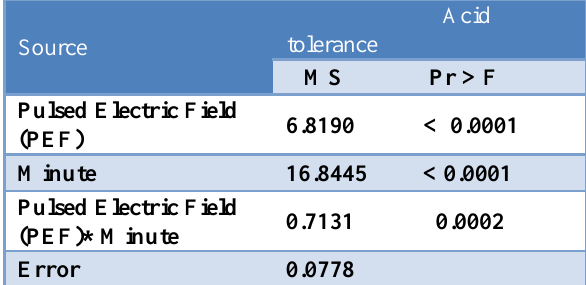
Table, 1: Mean square (MS) and Pr > F of mild pulsed electric field, minute and their interaction for acid tolerance of Lactobacillus acidophilus LA-K . Source